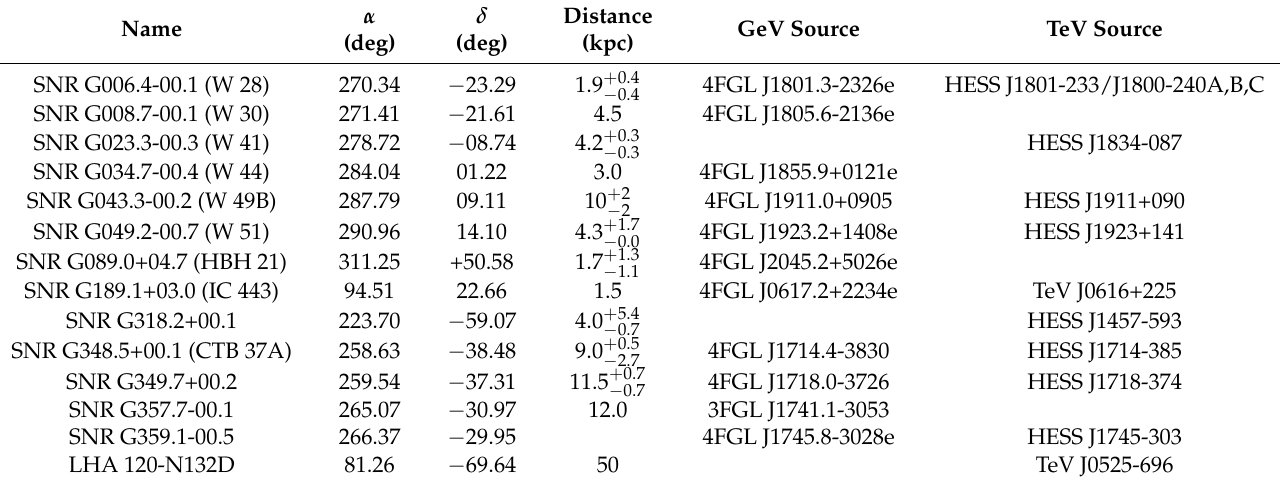
Table 1. List of the main established or candidate interacting SNRs detected in gamma